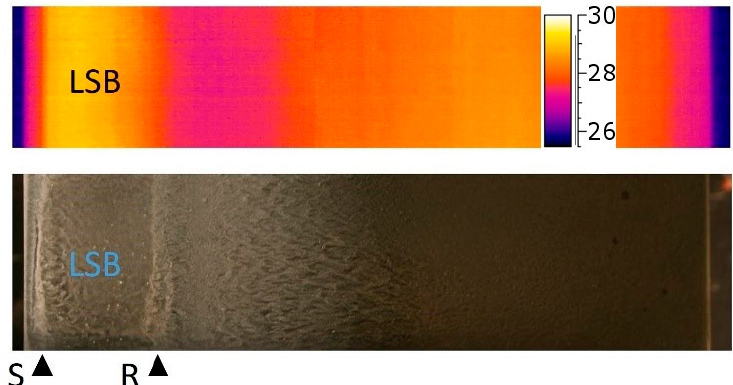
Figure 15. Infrared image ( top , temperature scale in degrees Celsius) and oil-flow visualization ( bottom ) for Re = 64,200 and α = 13.5 degrees. (Reprinted from [29]).